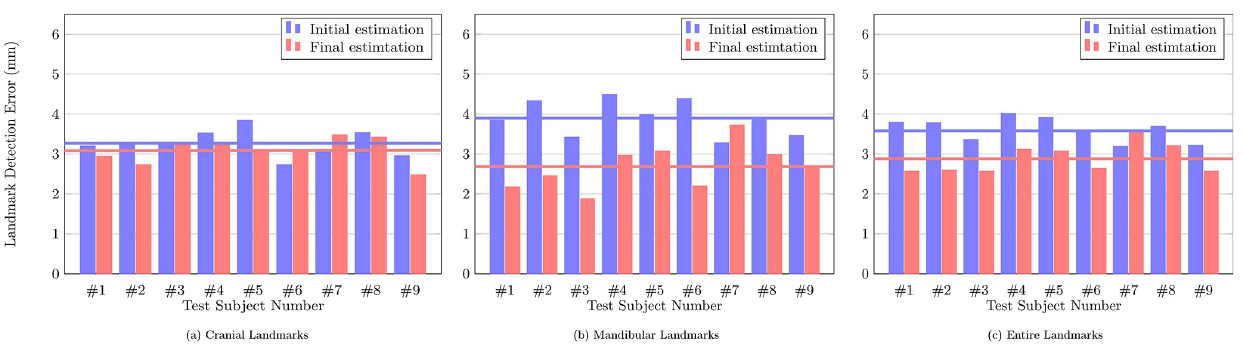
Fig 10. The mean detection error of the cranial, mandibular, and all landmarks for each of the 9 test data. Blue bars represent the error from the initial estimation, red bars represent the error from the final estimation, and the lines represent the averaged error over test subjects. (a) Cranial Landmarks. (b) Mandibular Landmarks. (c) Entire